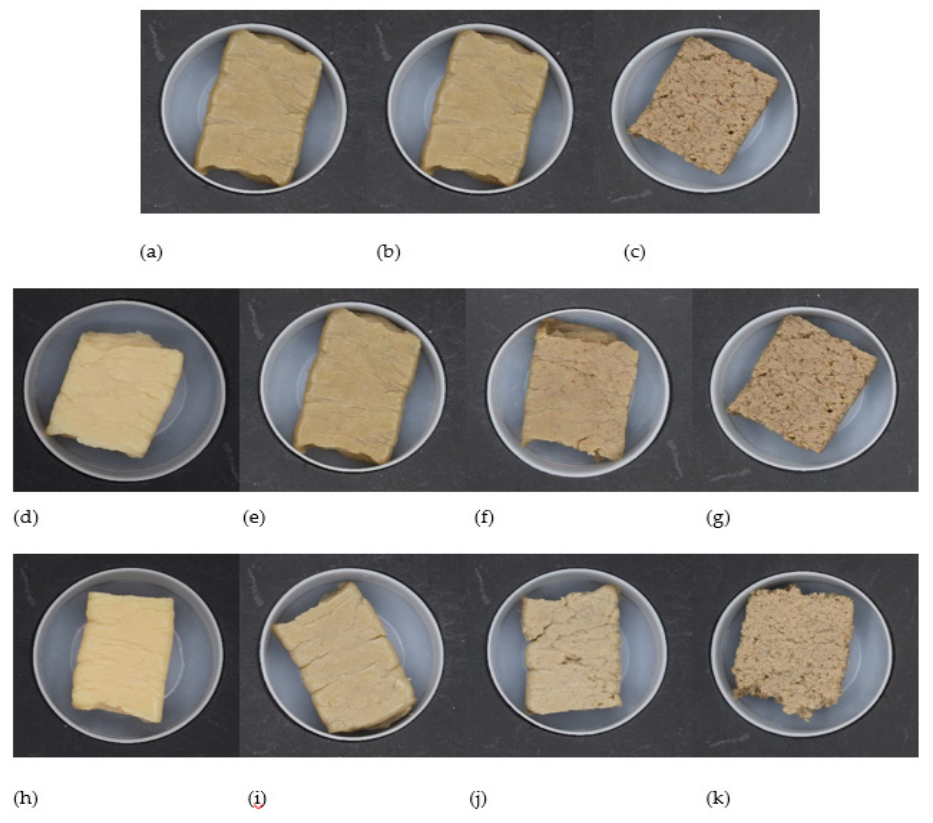
Figure 7. Images of extruded meat analogues with different formulations: ( a – c ) 20%, 40%, 60% HPC at 65% target moisture; ( d – g ) 0%, 20%, 40%, 60% HPC at 70% target moisture; ( h – k ) 0%, 20%, 40%, 60% HPC at 75% target moisture.